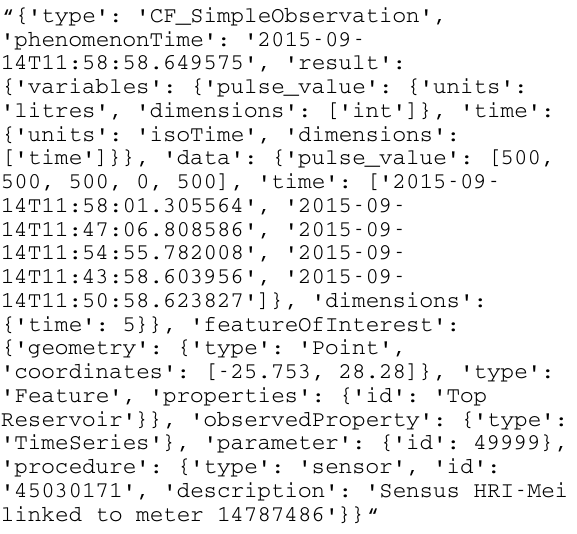
Figure 1: Swordfish Common Data Model